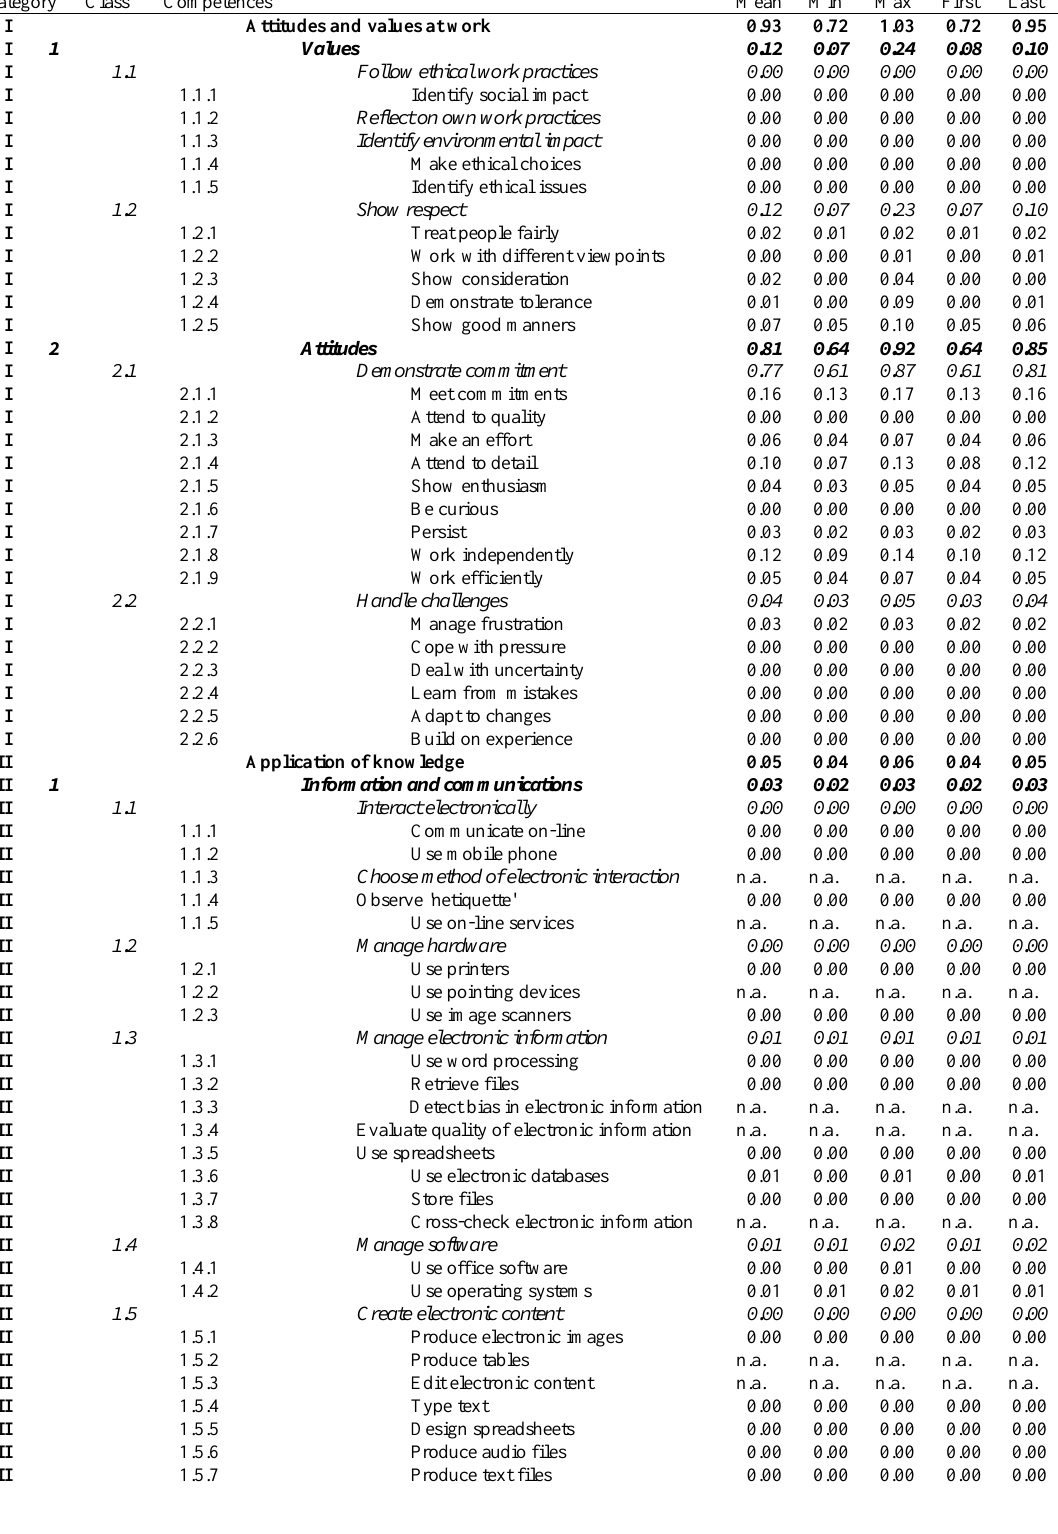
Table 3 : Detailed classification of competences, November 2012–December 2015 (number per job offer)